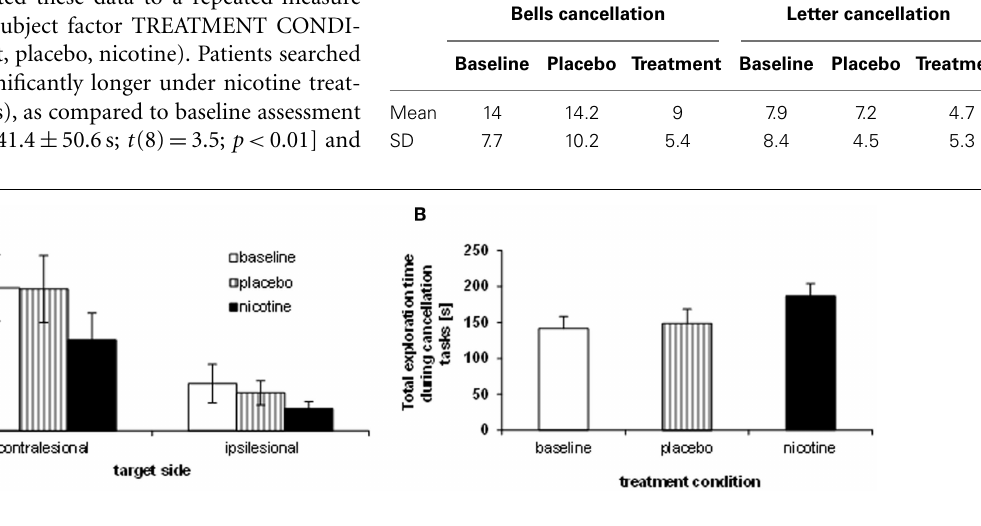
FIGURE 2 | Effects of treatment on neglect behavior . (A) Sum of omissions averaged over the three cancellation tasks, separately for each target side (contralesional, ipsilesional). (B) Average total exploration